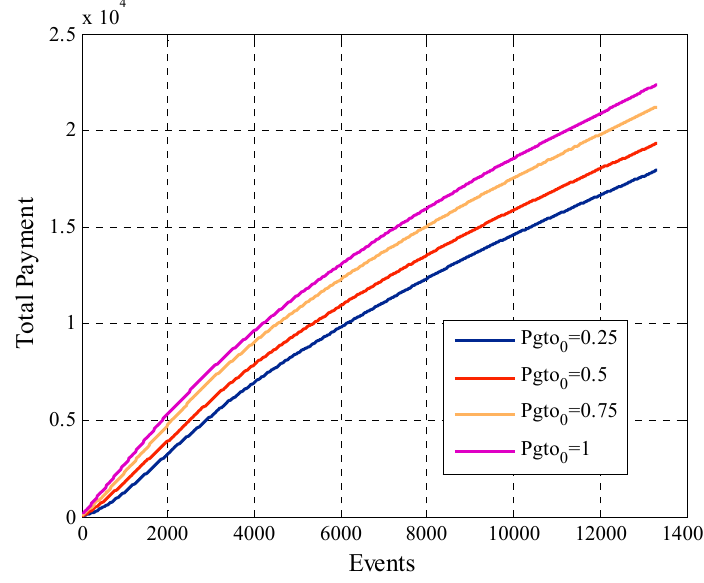
Figure 14. Total payment of the platform for configurations with di ff erent values of Pgto 0 .